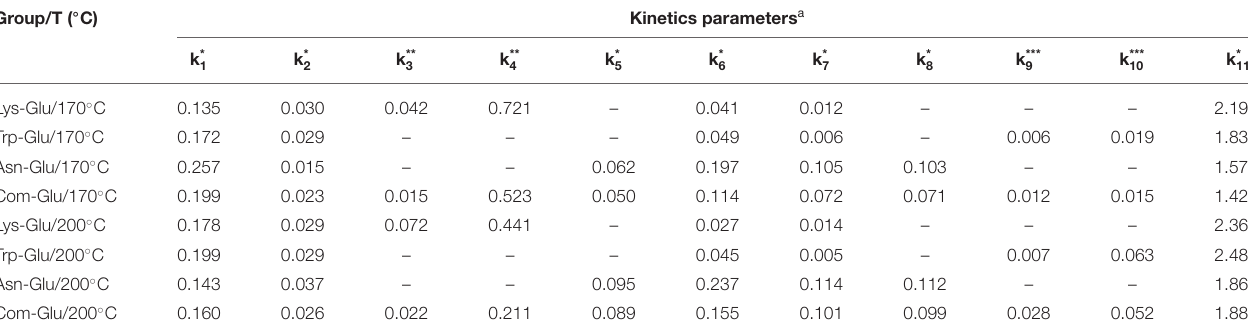
TABLE 1 | Estimation of kinetic parameters among different amino acid model systems. Group/T ( ◦